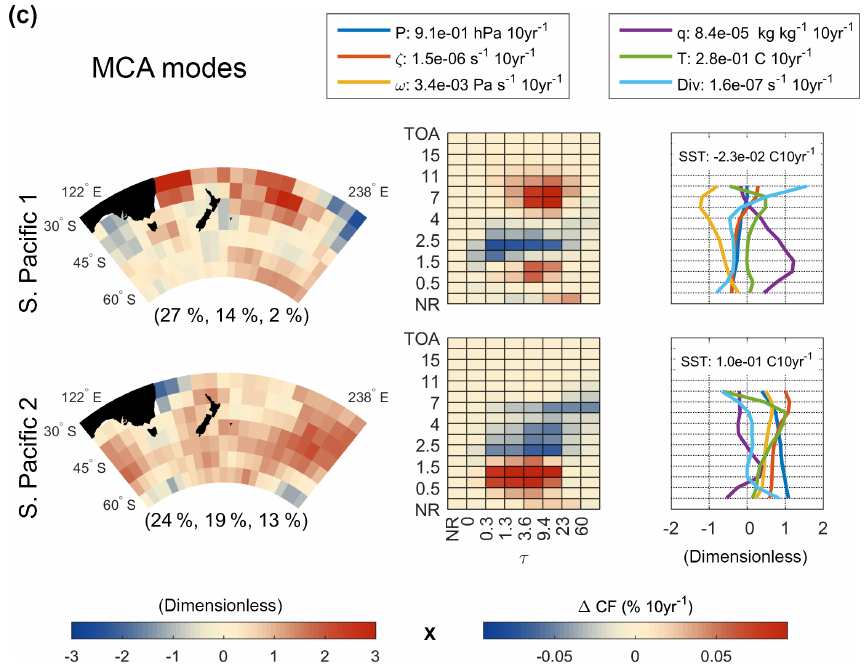
Figure 3. Results of the maximum covariance analysis between the MISR cloud fraction and the ECMWF reanalysis variable trends (2000– 2013). The MCA modes are computed by applying a singular value decomposition to the spatial covariance matrix between MISR cloud fraction joint histogram trends and trends in vertical profiles of six ERA-Interim variables and sea surface temperature, as described in Appendix A. The middle column shows the pattern of changing cloud fraction in CTH-OD space ( U ∗ in Appendix A) and the right column M shows the associated trends in the vertical profiles of the reanalysis variables ( U ∗ ). The left column shows the spatial loading patterns obtained E by projection of the ECMWF modes on the far right onto the original trends. The spatial patterns are dimensionless, and the scales associated with the CTH-OD trend patterns are shown in the bottom right color bar, whereas the scales for the ERA-Interim profile trend patterns are shown in the legend near the top. The trend (due to each mode) at each latitude and longitude grid point is obtained by multiplication of the joint histogram or vertical profiles with the dimensionless spatial pattern on the left. Listed with each mode (in parentheses under the plot of the mode’s spatial loading pattern) is the fraction of the covariance explained by that mode, followed by the fraction of variance in the ECMWF and MISR data sets, respectively. A 5 ◦ latitude/longitude grid was